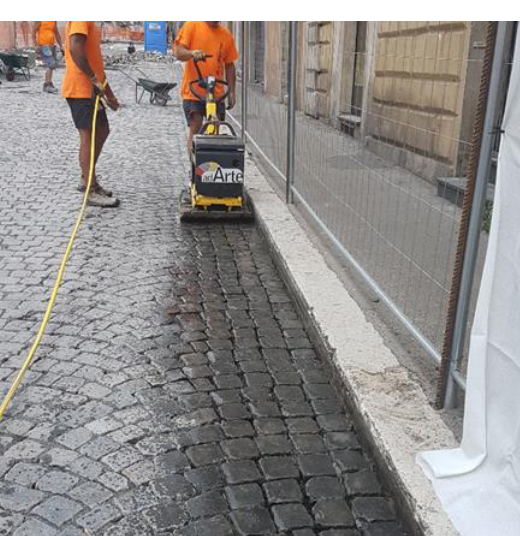
Figure 6. Third phase: sampietrini compaction.